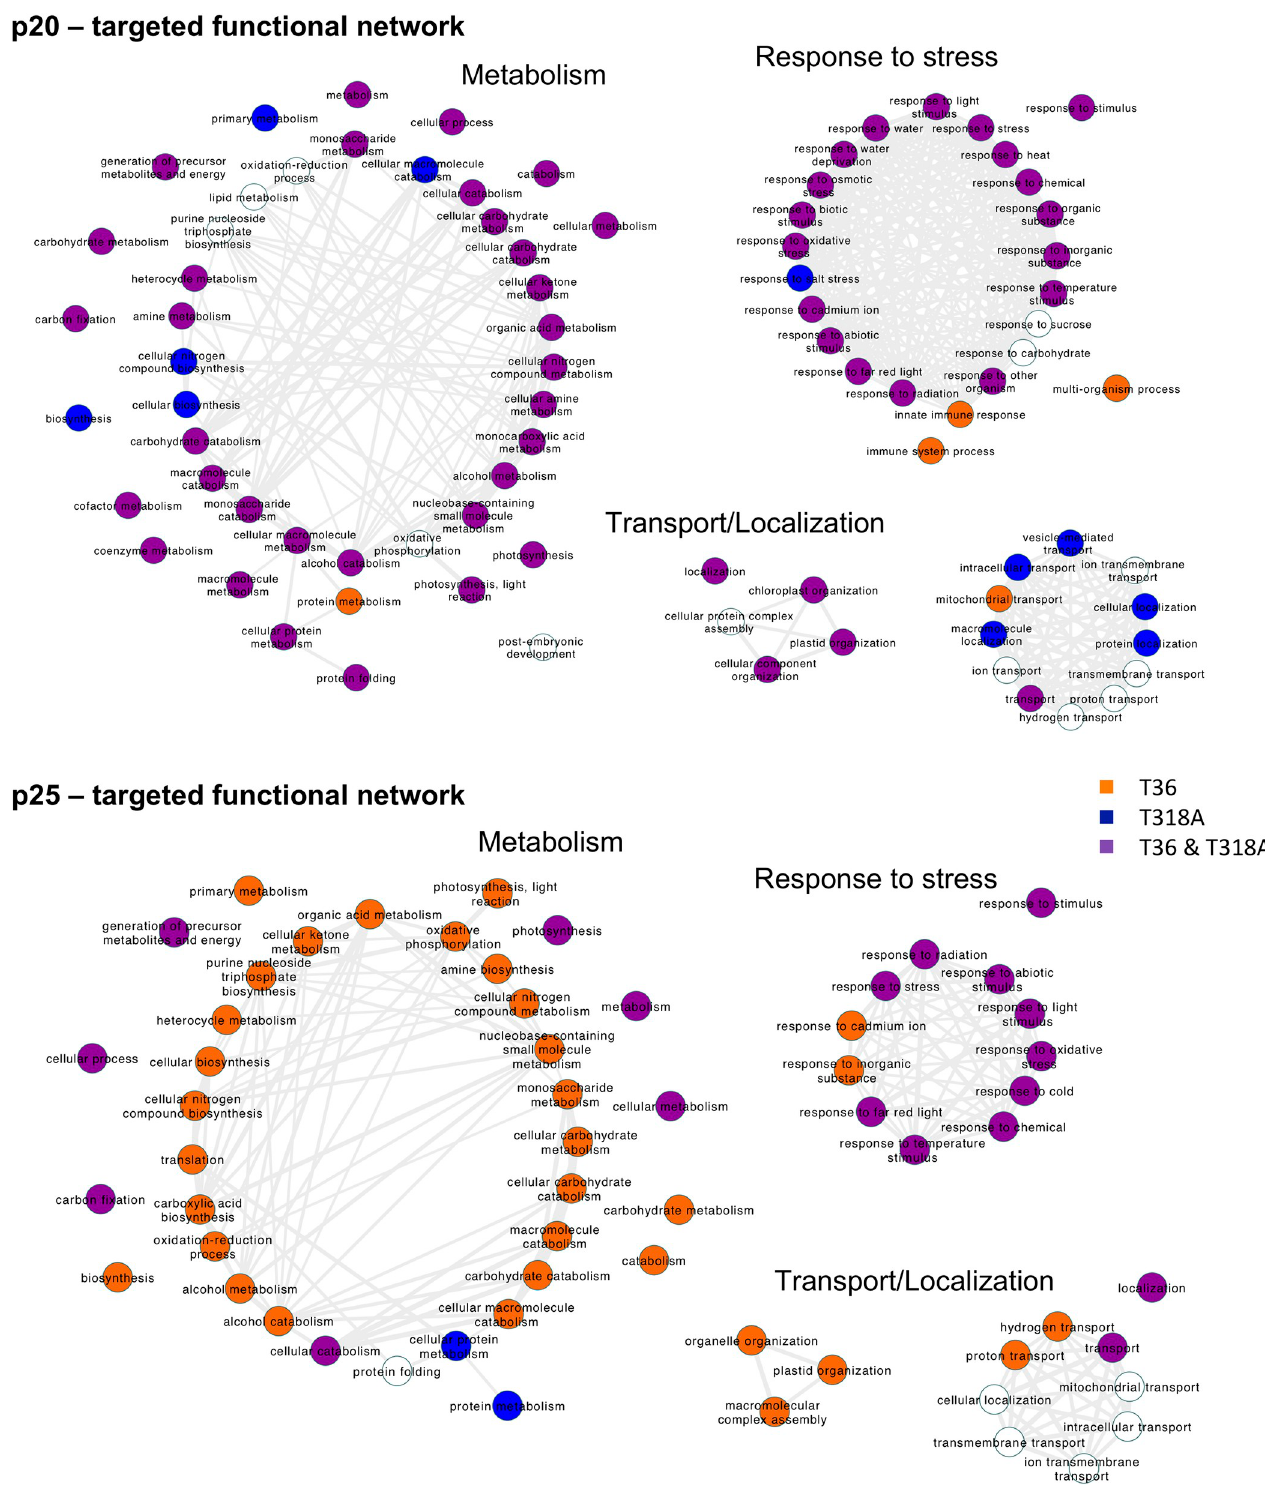
Fig 3. Functional analysis of the protein targets identified by AP-MS. Top: GO network for the CTV protein p20. Bottom: GO network for p25. Three main independent functional modules are shown (functions sharing elements are connected). Colors indicate the CTV isolate (T36 or T318A) from which the target was identified. White terms only appear in the functional analysis when all interactors, irrespective of the isolate, are merged.